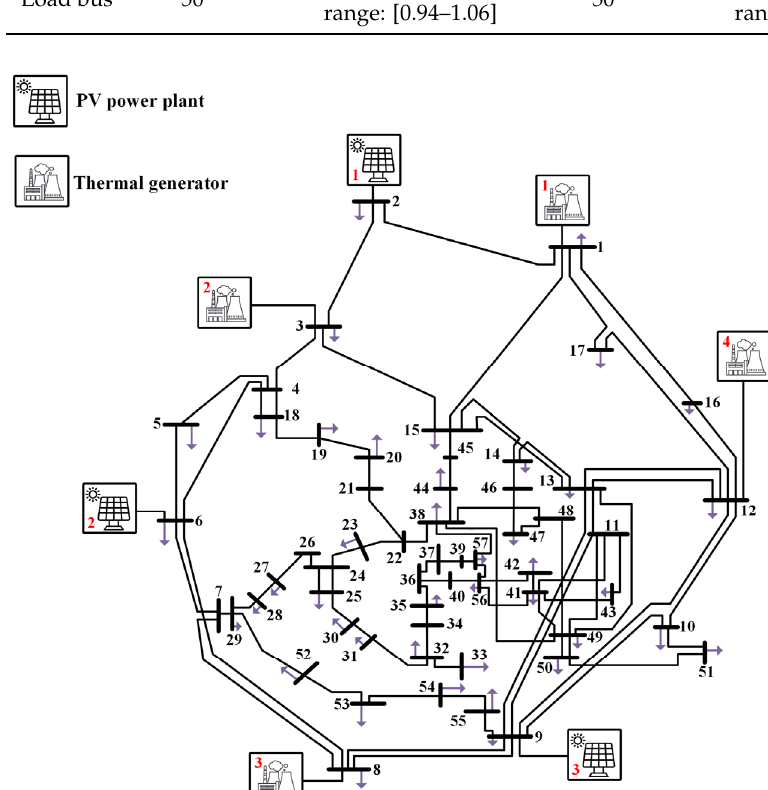
Table 2. The parameters of the three solar photovoltaic plants.